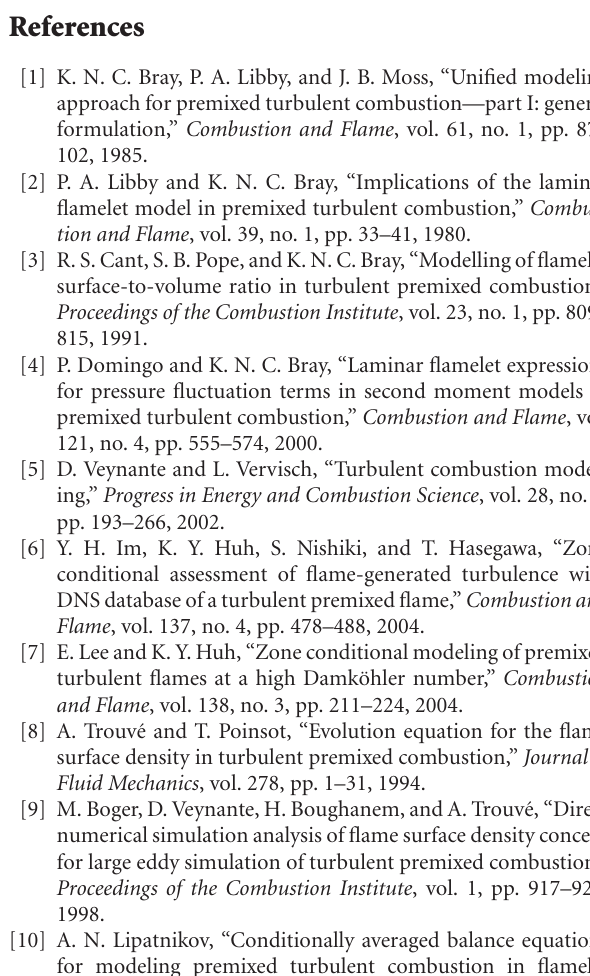
Figure 7: (a) Variations of ( u 1 u 1 ) across the flame